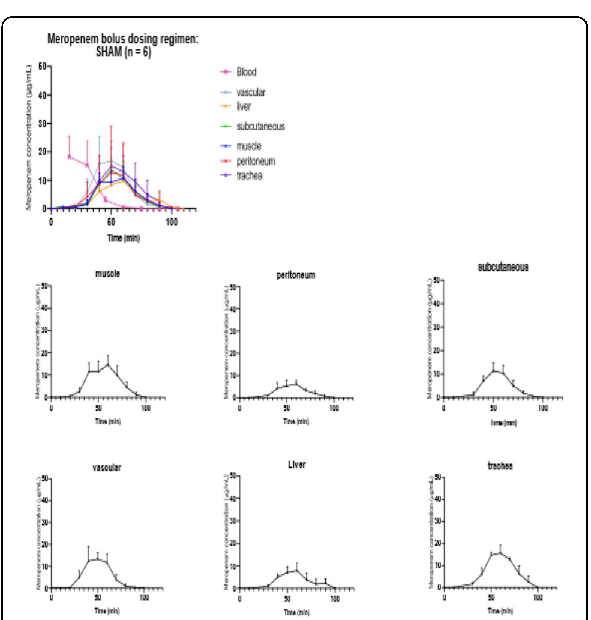
Fig. 2 (abstract 001019). Tissue concentration/time profiles following a meropenem bolus in sham rats at